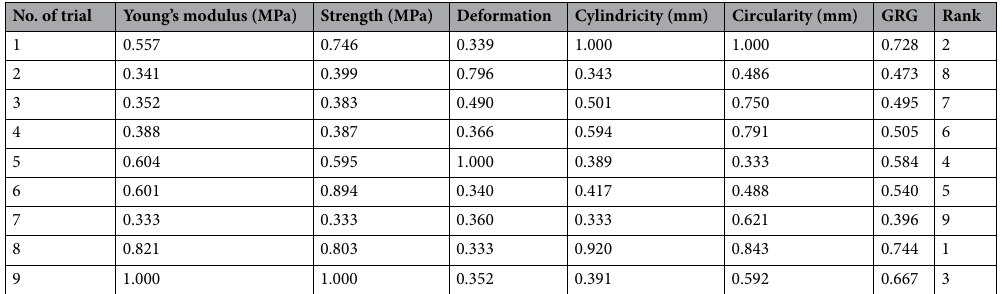
Table 7. Grey relation coefficient.